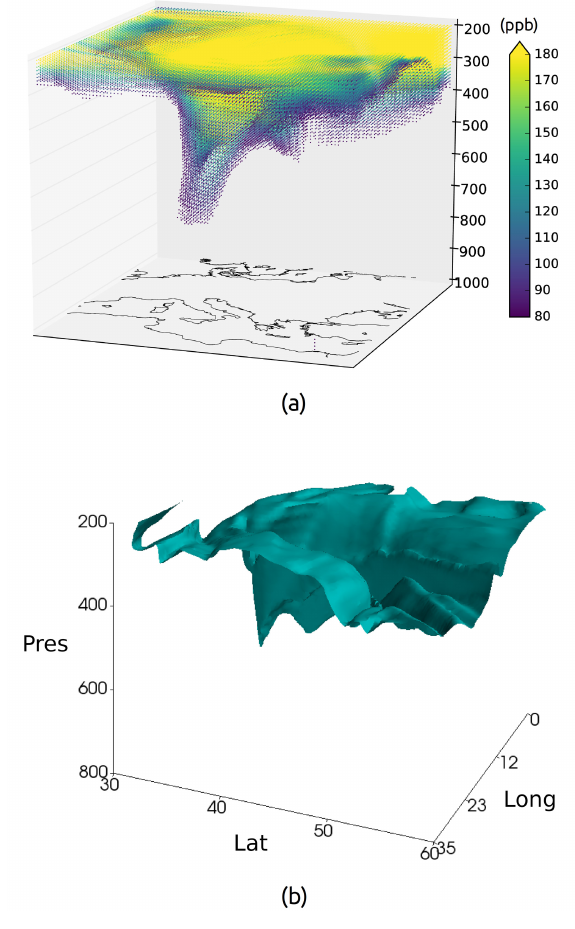
Figure 8. (a) Three-dimensional (longitude, latitude, pressure (hPa)) spatial distribution of IFS ozone concentrations exceeding 80ppb at 00:00Z on 6 January 2017. (b) Three-dimensional (longi- tude, latitude, pressure (hPa)) IFS ozone concentrations’ isosurface of 100ppb at 00:00Z on 6 January